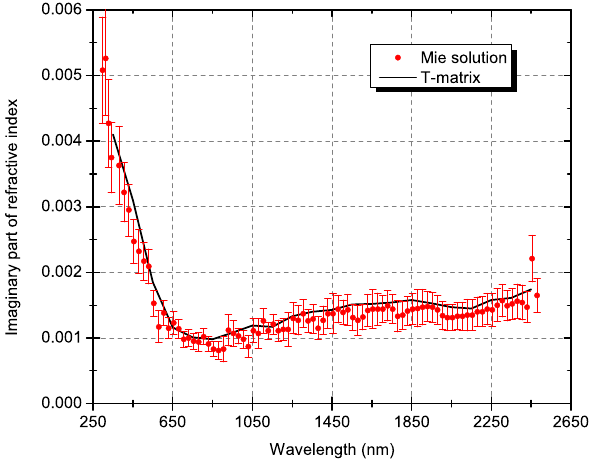
Figure 10. Imaginary part of the complex refractive index calculated for fine particles by Mie Theory and T-Matrix (for an aspect ratio of 1.5).